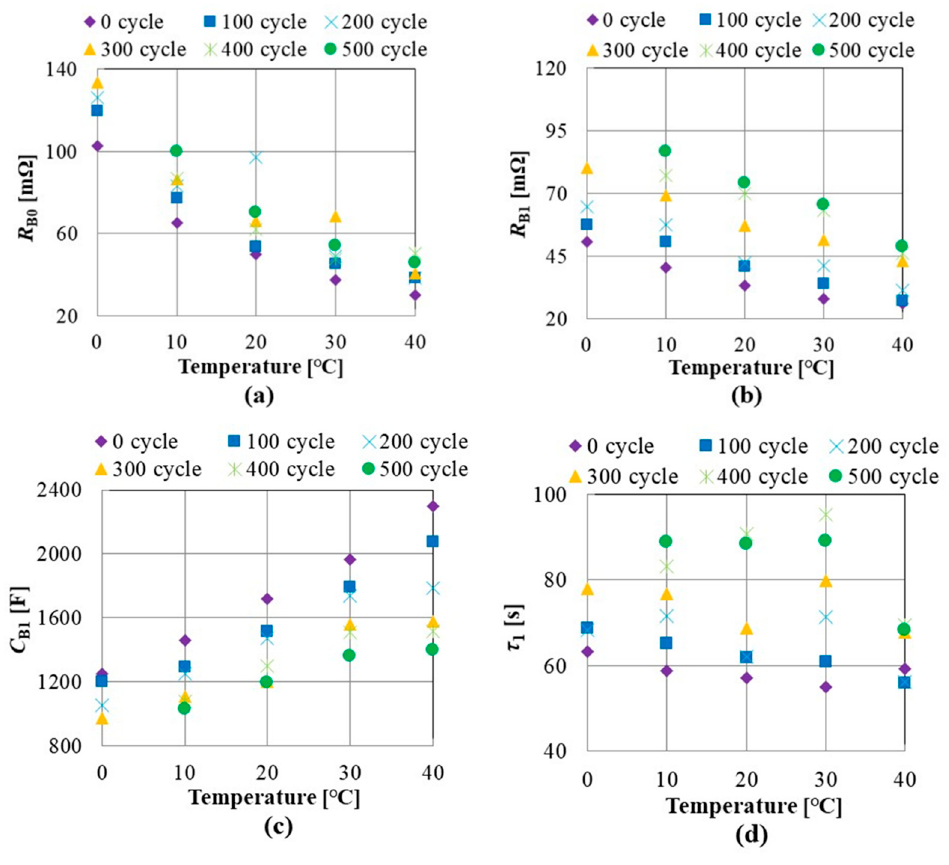
Figure 10. Temperature dependence of equivalent circuit parameters. ( a ) R B0 . ( b ) R B1 . ( c ) C B1 . ( d ) τ 1 .